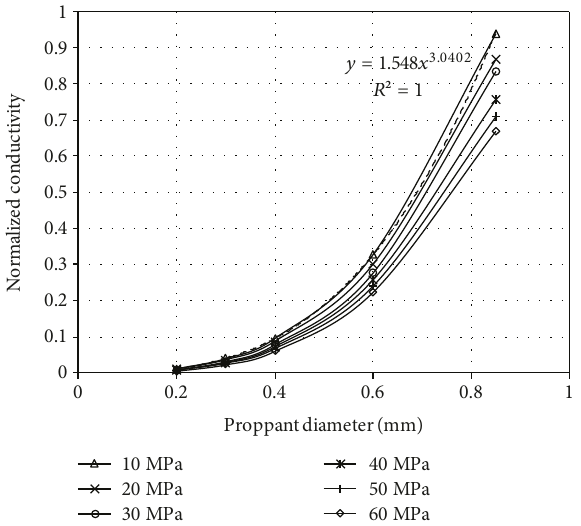
Figure 6: E ff ect of rock viscosity on conductivity at di ff erent times.